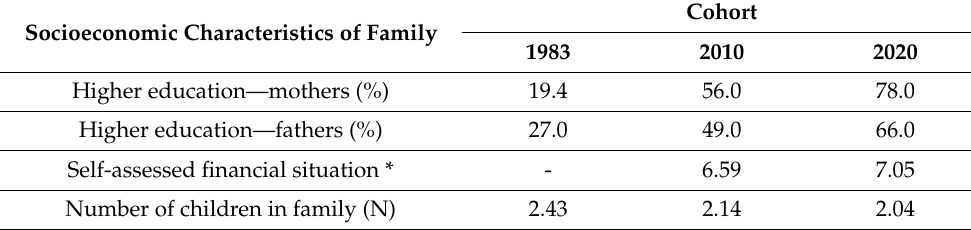
Cohort 1983 2010